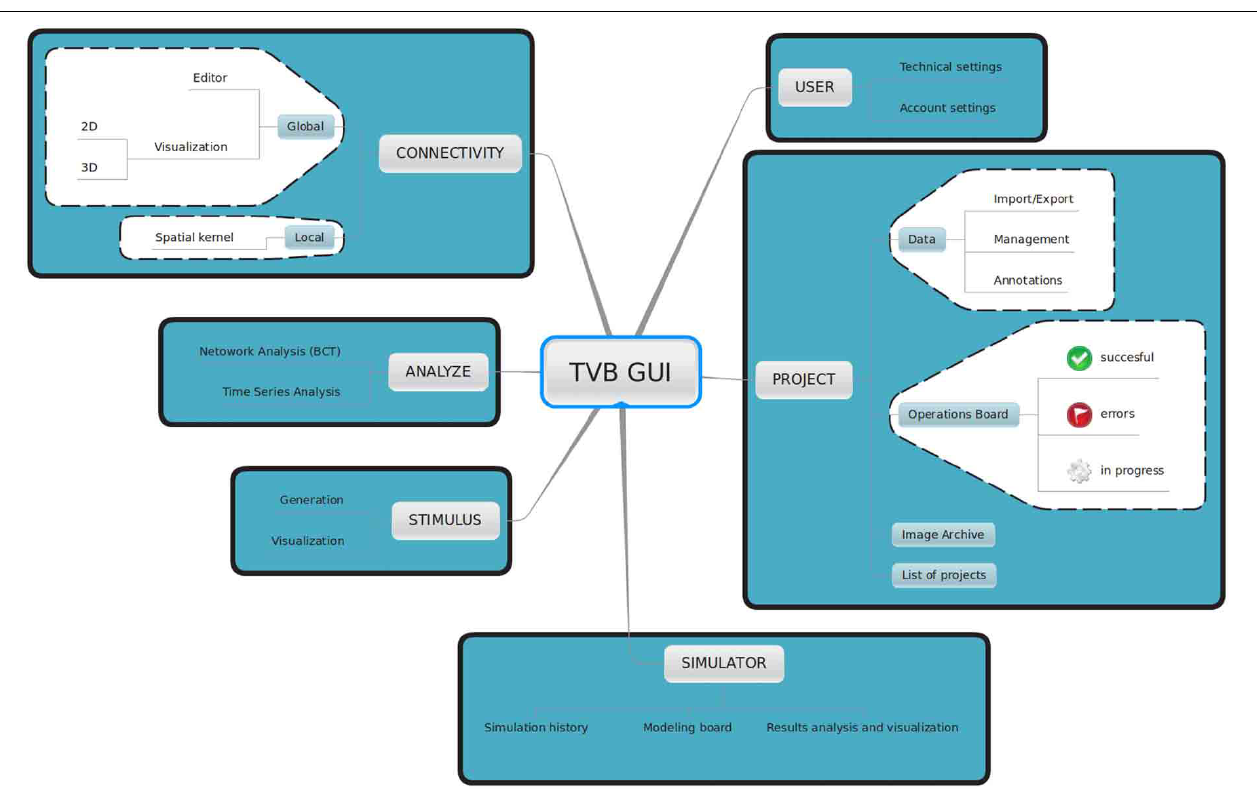
FIGURE 2 | Main working areas of The Virtual Brain ’s web interface: in USER personal information (account settings) as well as hardware and software preferences (technical settings) are configured. Through the PROJECT area users access and organize their projects, data, figures and the operations dashboard. Input and output simulated data can be exported in HDF5 format and may be used outside of the framework. Brain network models and execution of simulations are configured and launched,